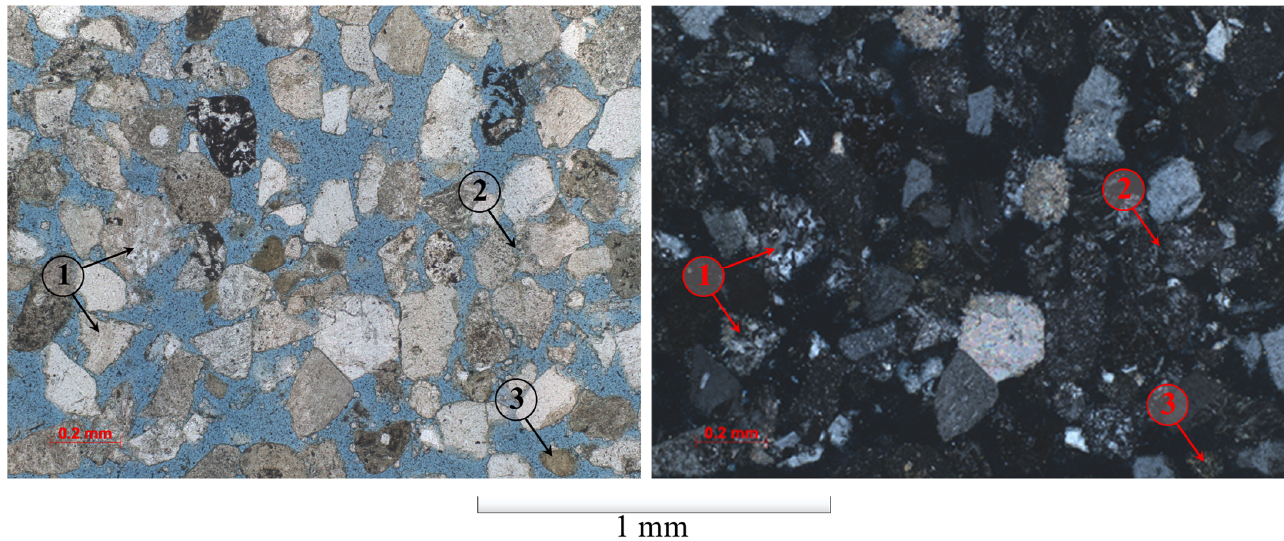
Figure 3. Photo of oil sand thin section with quartz rock fragments (1), analcime (2), and effusive rock fragments (3), without an analyzer (left) and with an analyzer (right).